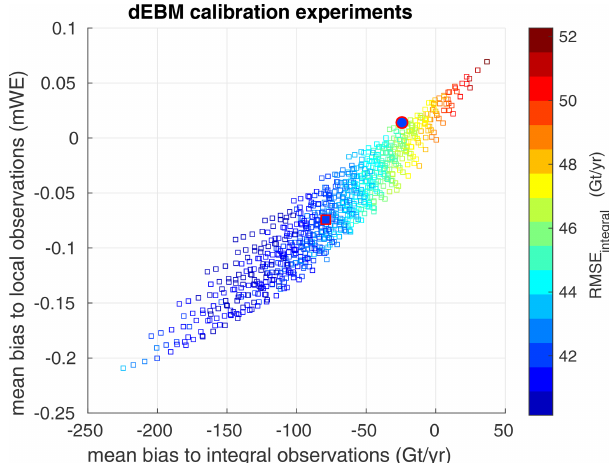
Figure 4. Mean bias of calibration experiments to integral obser- vations as a function of the mean bias to local observations. The color represents the root-mean-square error of annual variations in the calibration experiments relative to the annual variations in the integral observations after the respective mean bias was removed. The experiment with the parameter combination which was selected for all following experiments is highlighted as a filled square with red borders. Also shown is experiment dEBM MAR , ERA as a solid circle, which uses the same selected parameter combination but dif- ferent forcing (see Sect.